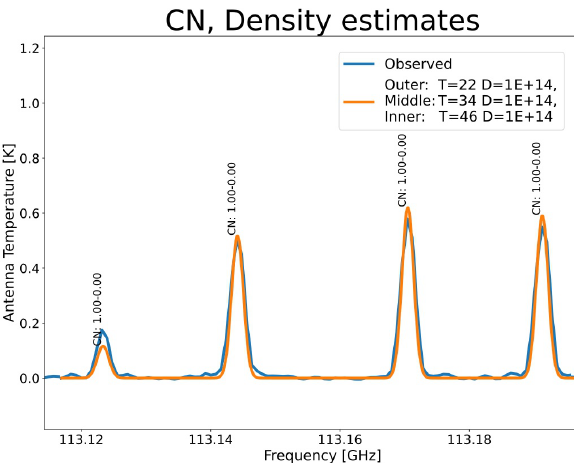
Figure 7. Fitting of CN lines with a 3 layered model.